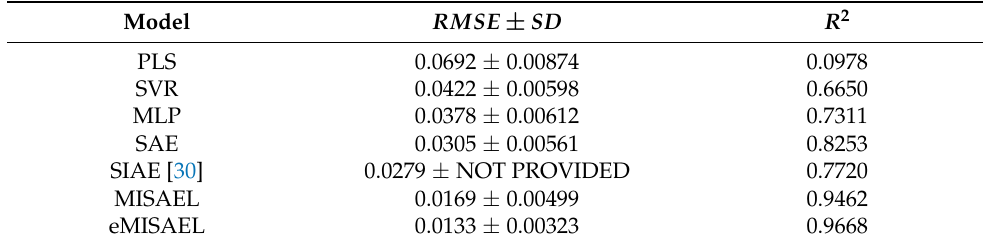
Table 4. Prediction performance of SRU soft-sensor